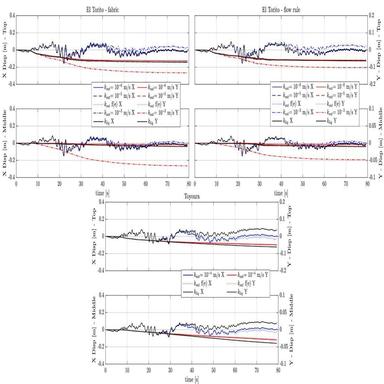
Horizontal and vertical displacements time-histories at the top and of site response models for both sands and calibrations.